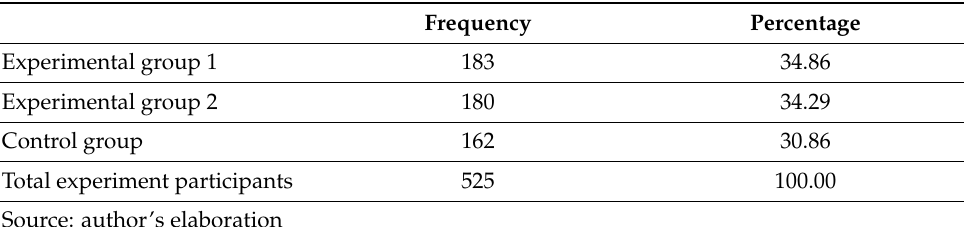
Table 1. Sample summary: Distribution of experiment